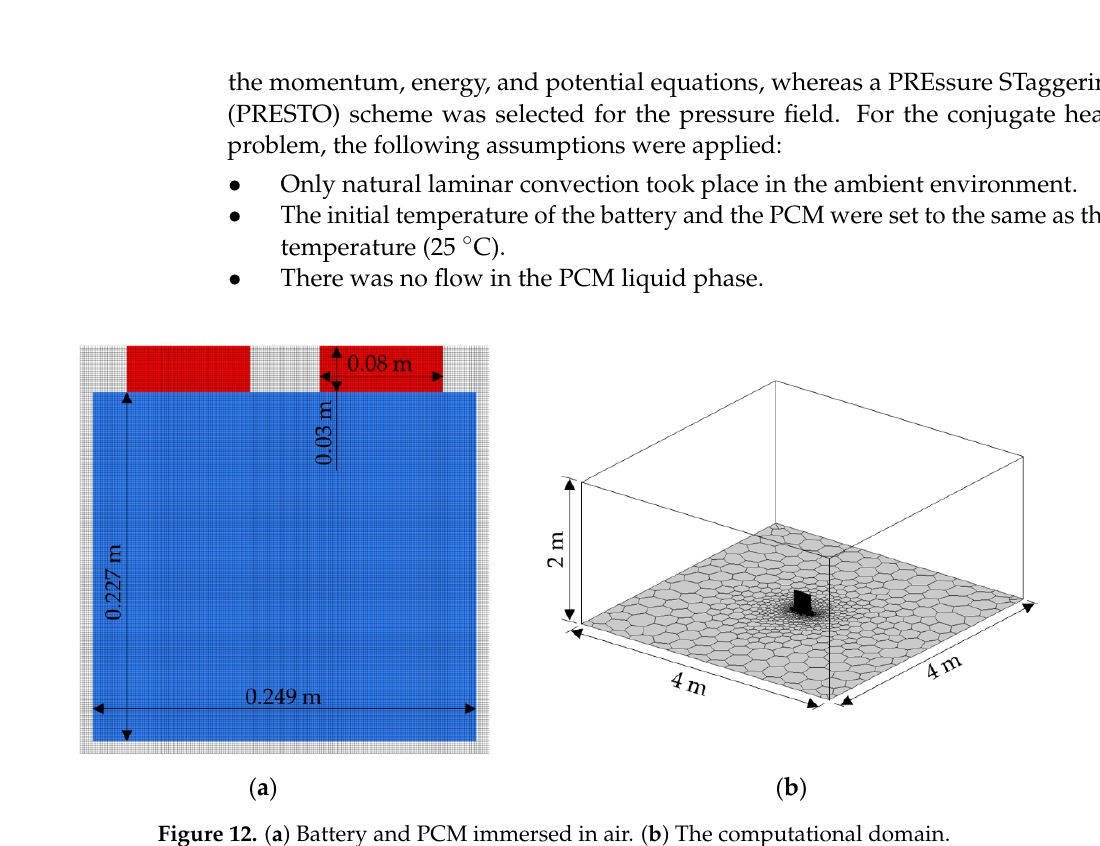
Figure 12. ( a ) Battery and PCM immersed in air. ( b ) The computational domain.